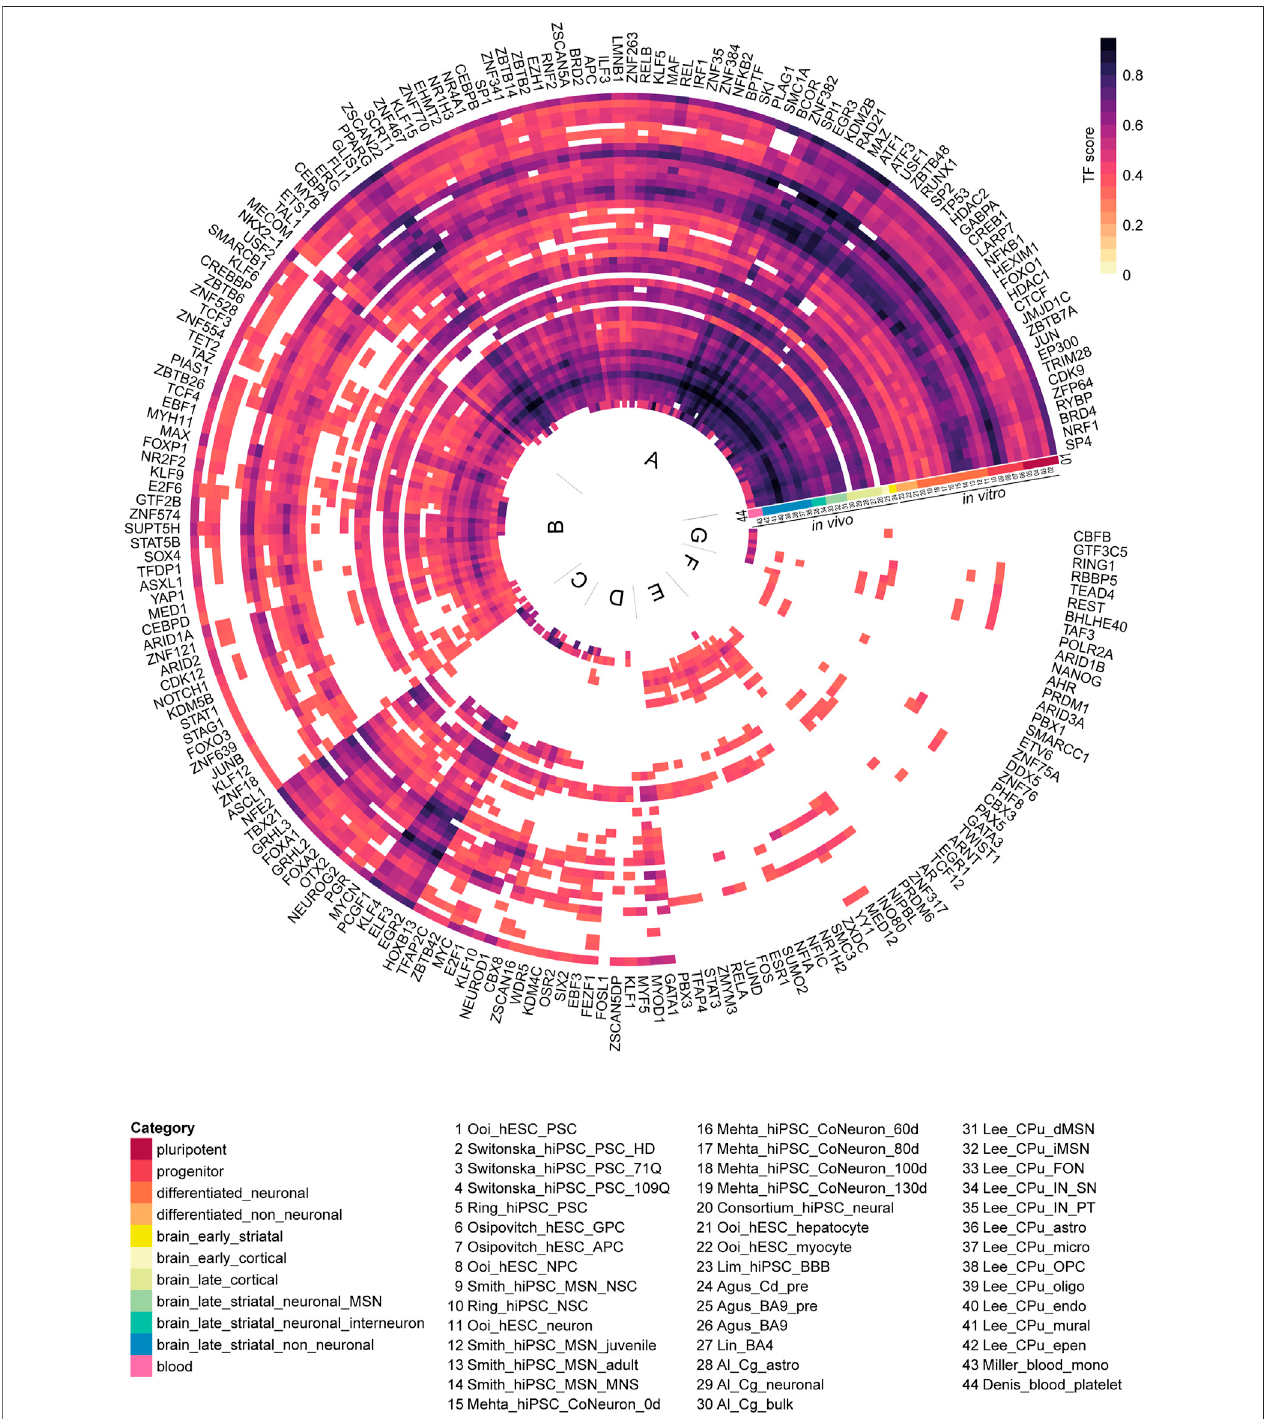
FIGURE 5 | Potential enriched regulators for all 44 human differentially expressed gene (DEG) datasets. Each ring is a human DEG dataset, each spoke is a regulator. The regulator activity score was de fi ned as the ratio of DEGs controlled by a regulator to the total number of DEGs in a dataset. For each dataset, regulators with an activity score higher than 0.3 were shown ( n (cid:1) 205). The regulators were clustered using the Ward D2 method. Based on commonality in the 44 human DEG datasets, regulators can be divided into 7 groups (A to G). Abbreviations: CPu, caudate putamen; astro, astrocyte; epen, ependymal; endo, endothelial; IN, interneuron; PT, Pvalb/Th-expressing; MSN, medium spiny neuron; MNS, MAP2+ and NES/SOX2-; OPC, oligodendrocyte progenitor cell; oligo, oligodendrocyte; micro, microglia; NSC, neural stem cell; Cg, cingulate cortex; FON, Foxp2/Olfm3-expressing neuron; SN, Sst/Npy-expressing; dSPN/iSPN, direct/indirect pathway spinyprojectionneuron;mono,monocyte;NPC,neuralprogenitorcell;CoNeuron,corticalneuron;Cd,caudatenucleus;pre,presymptomatic;GPC,glialprogenitorcell; APC, astrocyte precursor cell; BBB, blood brain barrier.